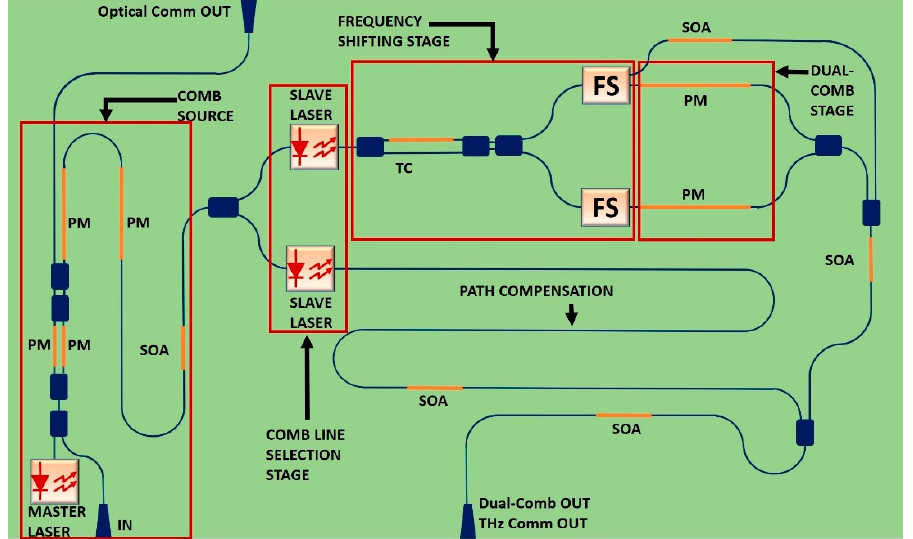
Figure 2. Left , sampled spectrum from 100 to 600 GHz. Right , three comb lines used to track, in real time, the Ammonia absorption line around 570 GHz.